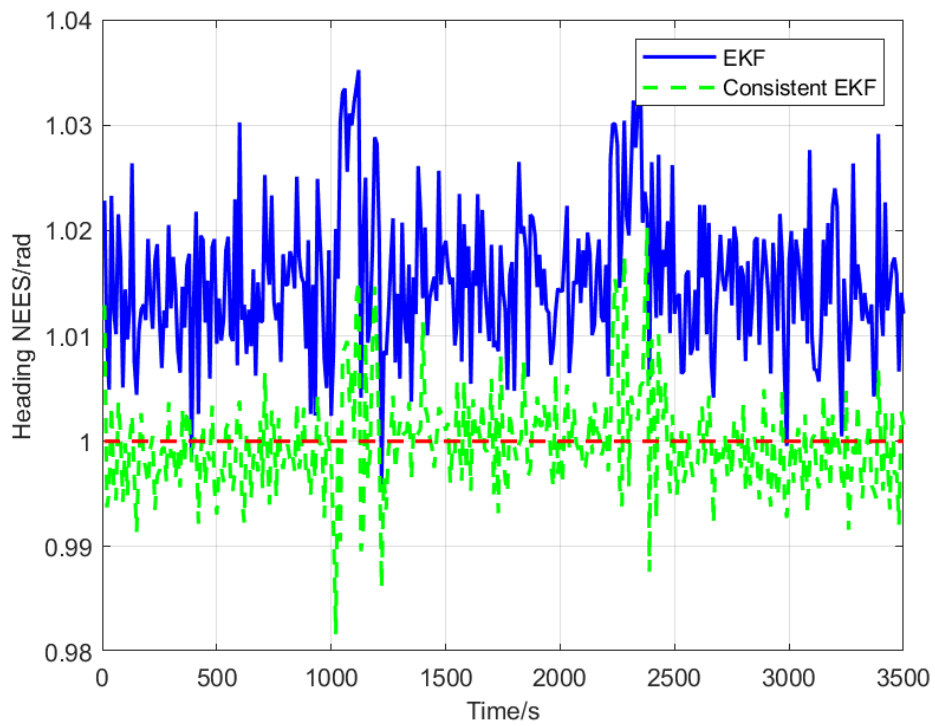
Figure 7. Normalized estimation error squared of